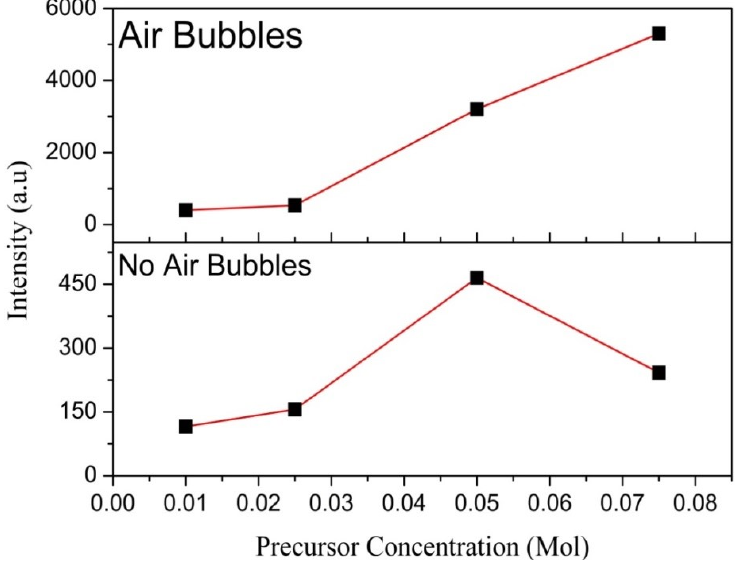
Figure 7 . Precursor concentrations versus intensity of ZnO nanorods along diffraction peak (002) Figure 7. Precursor concentrations versus intensity of ZnO nanorods along di ff raction peak (002) plane plane in the presence and absence of air bubbles. in the presence and absence of air